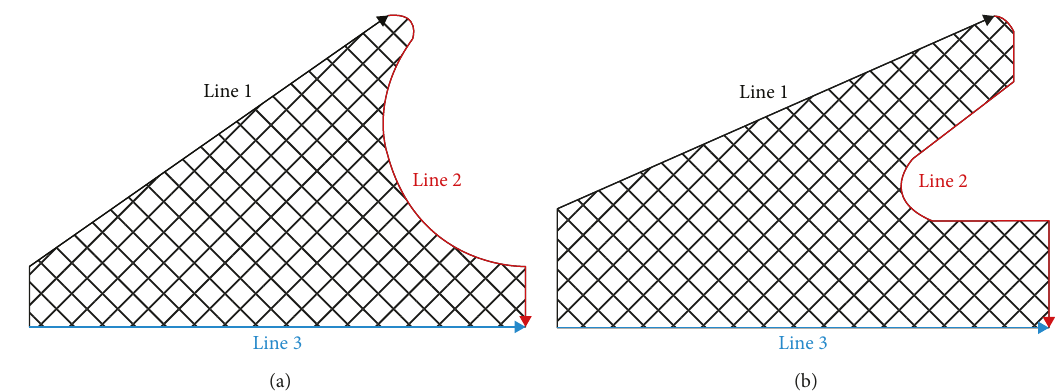
Figure 6: Extraction path of contact force in the rubber ring model: (a) before optimizing and (b) after